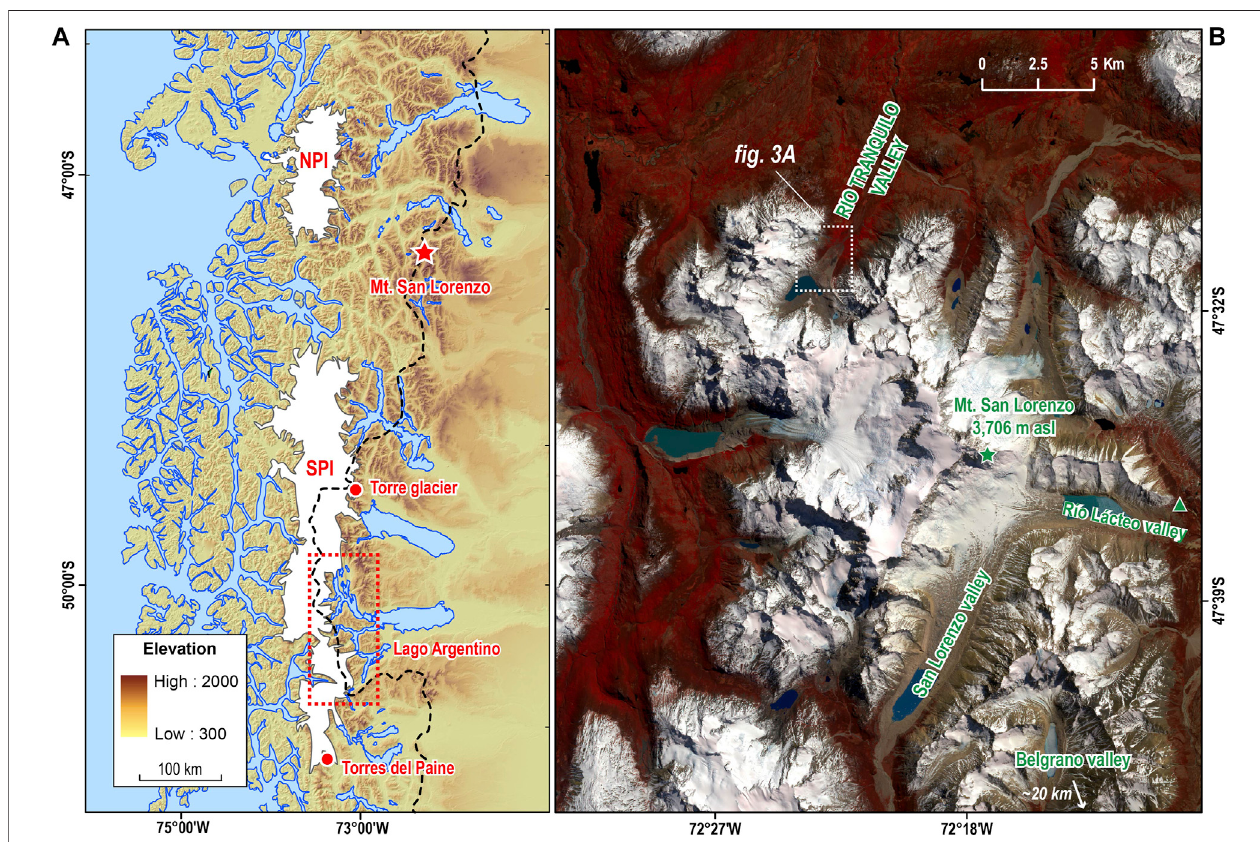
FIGURE 1 | Geographic setting of this and prior studies. (A) Regional overview of the Patagonian Ice fi elds and surrounding area. ALOS PALSAR composition (m asl) NPI, Northern Patagonian Ice fi eld; SPI, Southern Patagonia Ice fi eld. (B) Río Tranquilo valley, Mt. San Lorenzo. Sentinel 2 false color image (Infrared, 2016) showing the entire San Lorenzo massif and all the glaciers draining from its headwalls. Green star indicates Mt. San Lorenzo summit. Green triangle shows the approximated location of the available Holocene radiocarbon date (Mercer, 1968). Other sites discussed in the text are also shown.